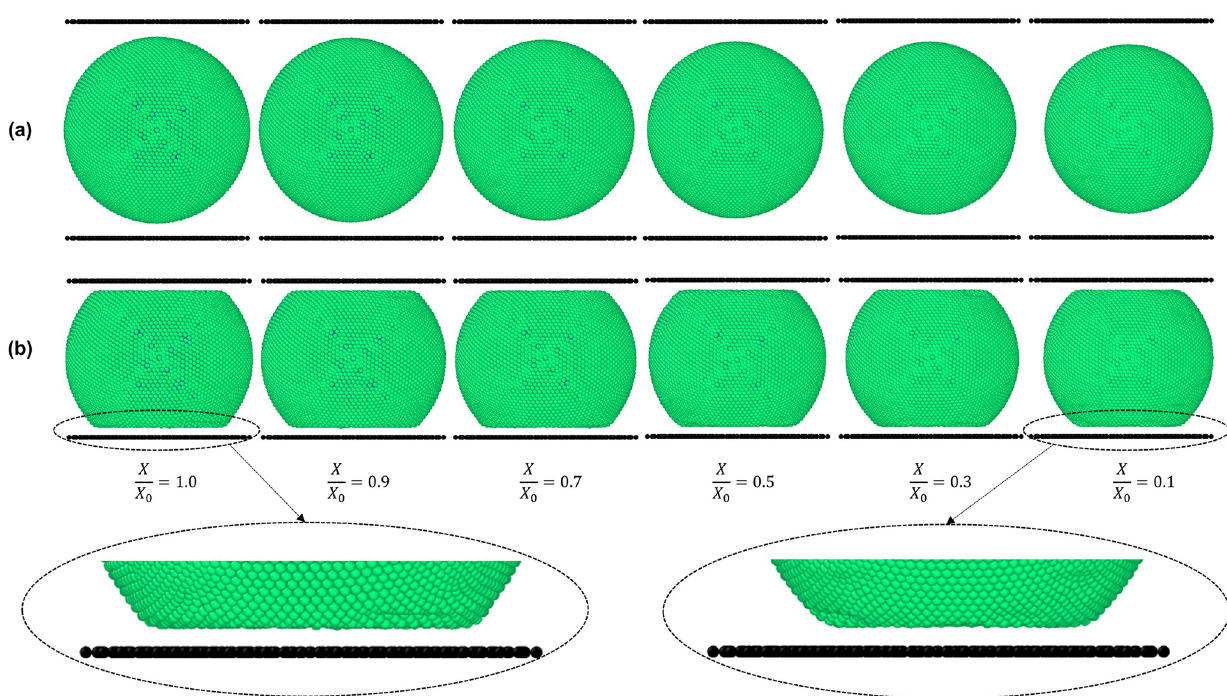
Fig 2. SPH-CG model predictions for (a) uncompressed and (b) compressed dried cells at different dryness levels at normal turgor pressure (200 is the normalised moisture content). kPa). ( X/X 0